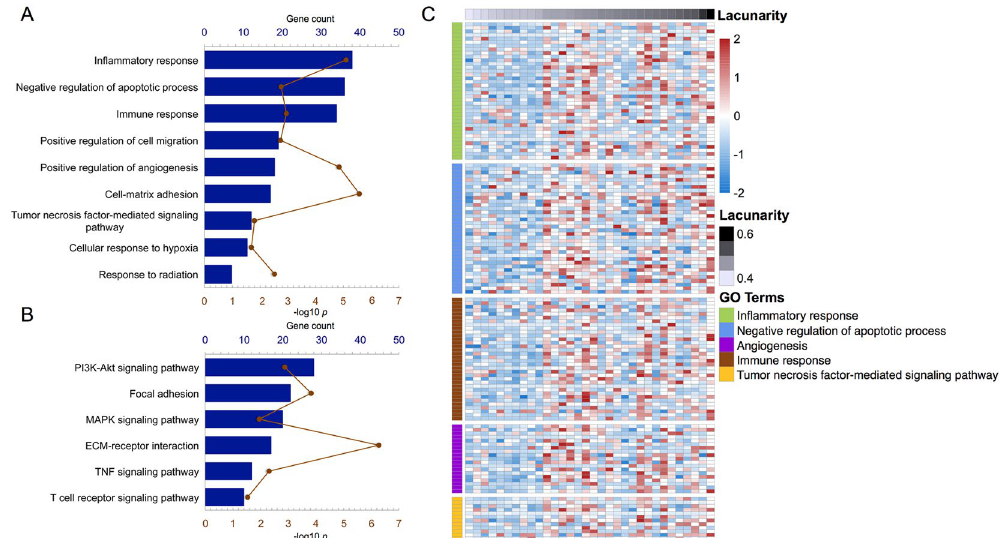
Figure 3. Gene ontology analysis for the lacunarity of necrosis in patients with glioblastoma. Biological processes ( A ) and pathways ( B ) associated with necrosis are shown. Genes involved in the representative biological processes are shown in ( C